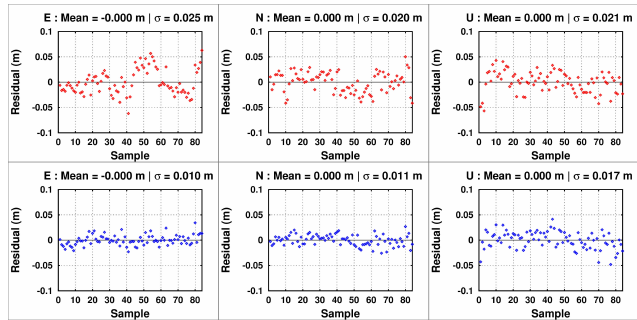
Figure 9: Comparison of residuals with and without delay planimetric components. In fact, variations of the UAV trajectory according to the vertical component are very low. Relative accu- racy obtained is at centimeter level between trajectory computed with GPS data and image trajectory computed after bundle block adjustement.